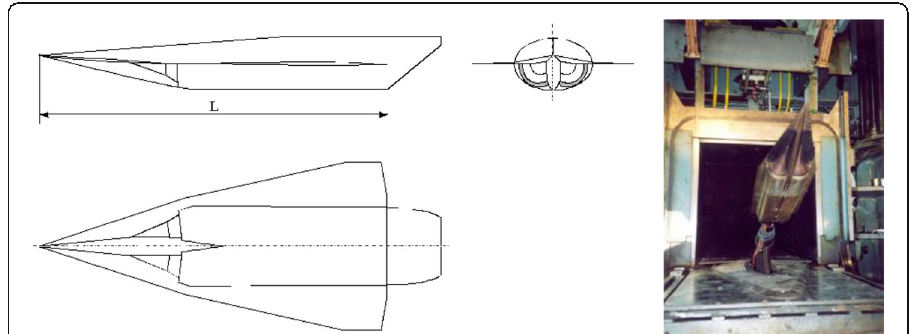
Fig. 9 Configuration of vehicle based on waverider